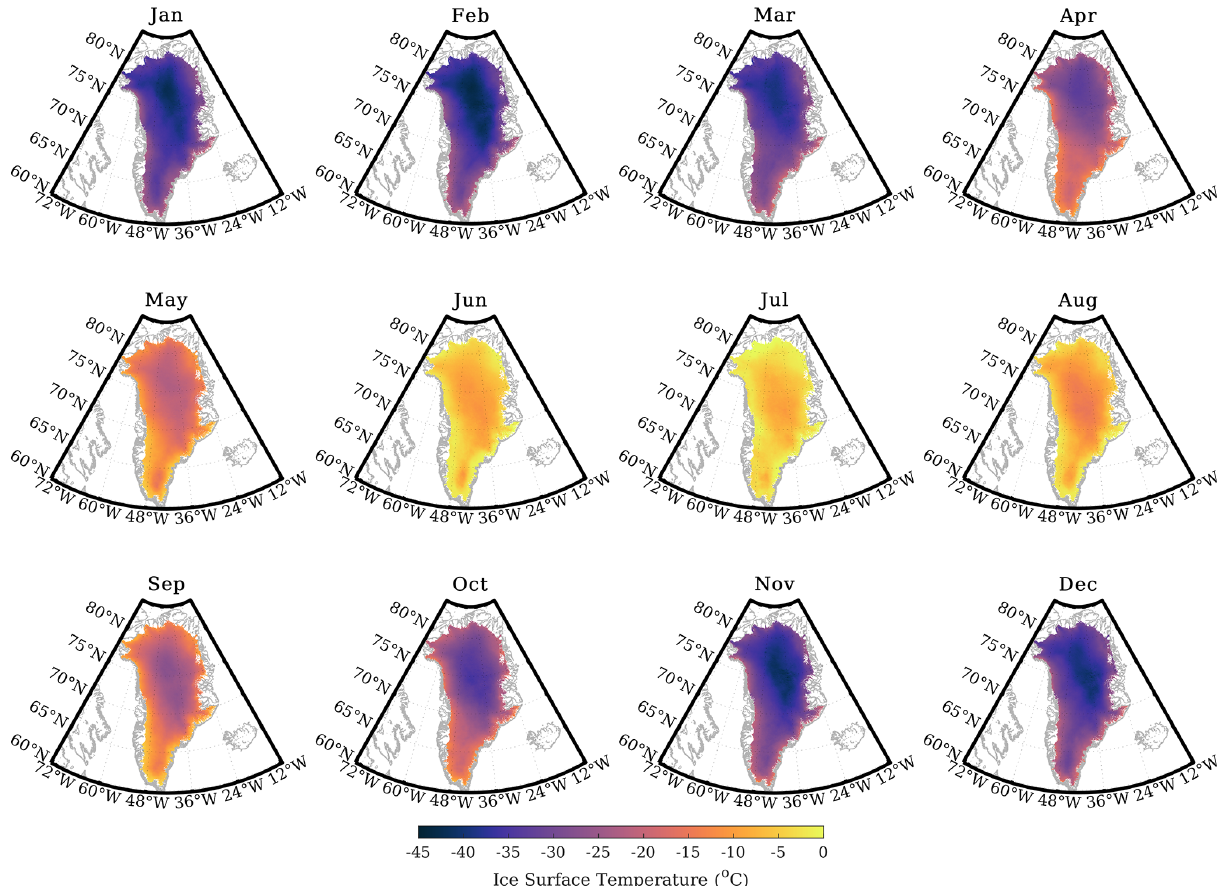
Figure 9. Mean monthly ice surface temperature over the Greenland Ice Sheet for 2012, from the L4 IST product.